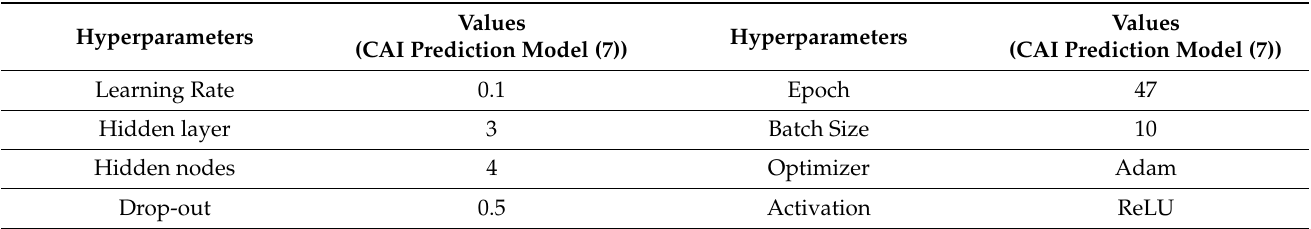
Table 3. Setting of hyperparameters in DNN. The CAI of the station is predicted using six pollutants’ data as an independent variable (CAI prediction models).